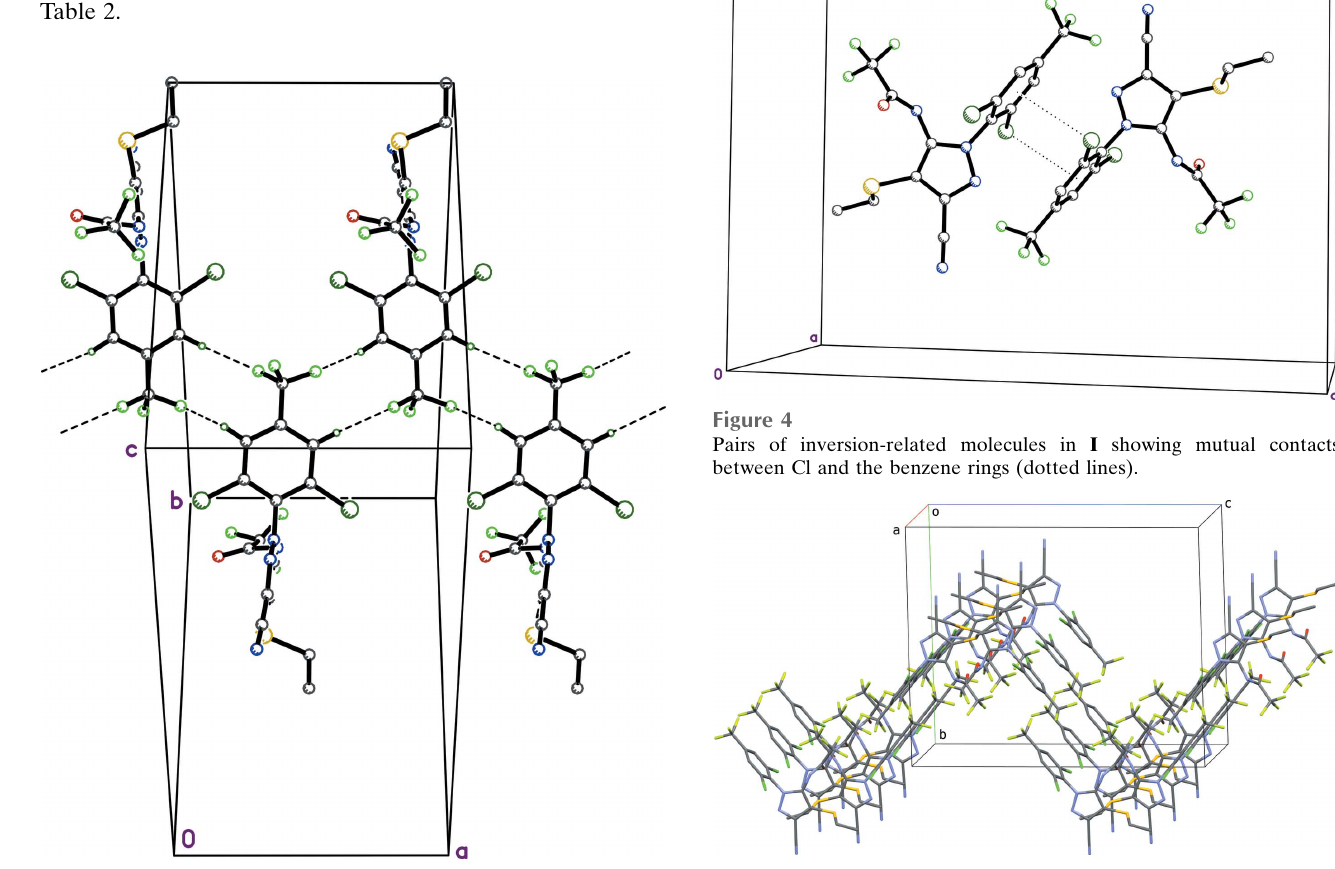
Figure 5 A partial packing plot of I showing pleated sheets that extend in the ac plane. Diagram generated using Mercury (Macrae et al. , 2020).